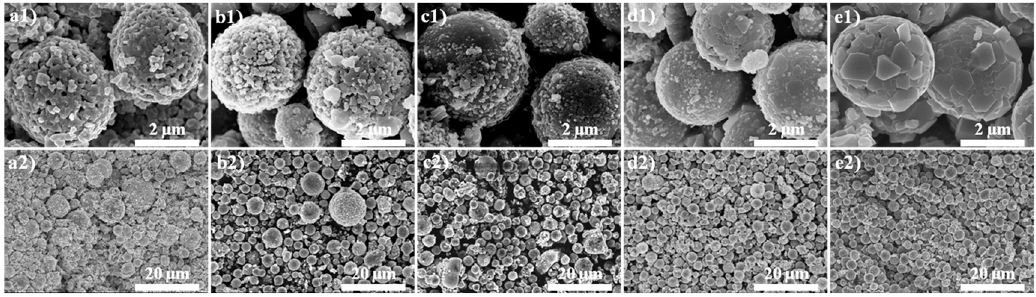
Figure 4. High- and low-resolution SEM images of ( a1 , a2 ) S 01 ; ( b1 , b2 ) S 12 ; ( c1 , c2 ) S 11 ; ( d1 , d2 ) S 21 ; ( e1 , e2 ) S 10 . Table 3. BET surface areas of the LNMO samples prepared by mixed precipitants of (NH 4 ) 2 CO 3 and Na 2 CO 3 with different molar ratios.